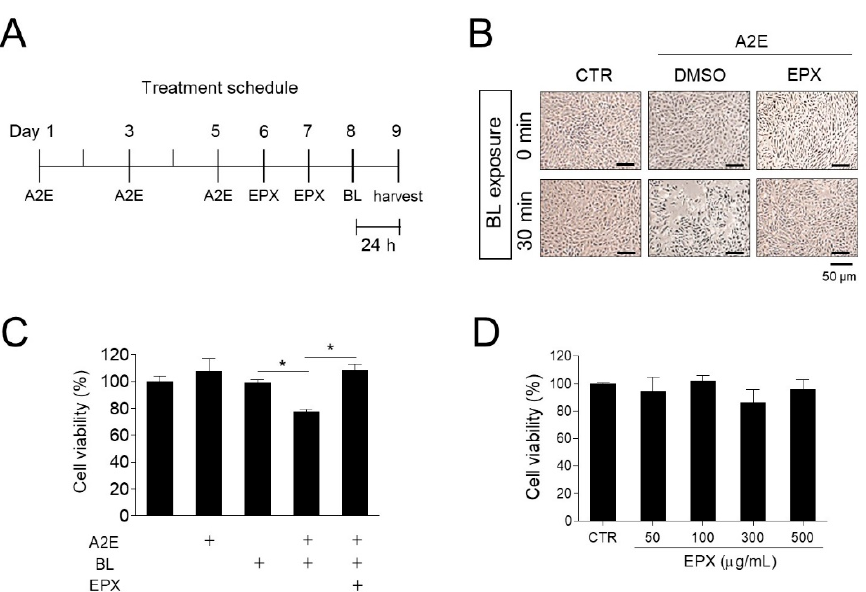
Figure 2. Protective effect of EPX on phototoxicity induced by blue light in A2E-laden ARPE-19 cells. ( A ) Treatment schedule of A2E and EPX. A2E—Bis-retinoid N-retinylidene-N-retinylethanolamine; EPX—eggplant extract ; BL—blue light. ( B , C ) Protection of retinal cells by EPX. ARPE-19 cells were treated with fresh A2E (20 μ M) every 2 days for a period of 6 days and then exposed twice to vehicle (DMSO) or EPX (25 μ g/mL) for 48 h. Next, the cells were exposed to blue light (BL, 430 nm, 8000 lux) for 30 min. After incubation for 24 h, cell viability was visualized using an inverted phase-contrast microscope (B) and measured using EZ-Cytox (C). CTR—control; DMSO—dimethyl sulfoxide; +—sample treatment. The results are presented as the mean ± S.D. ( n = 3); * p < 0.05. ( D ) Viability of ARPE-19 cells treated with EPX (50 to 500 μ g/mL) for 24 h.